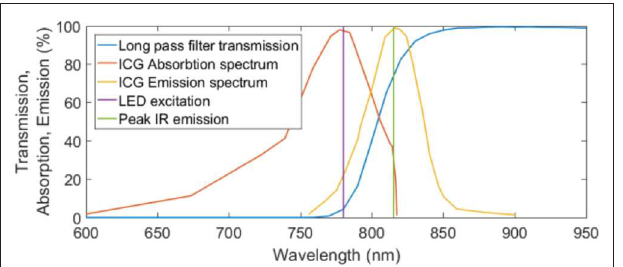
FIGURE 3 | Transmission, absorption, and emission spectra for the MIDOPT filter, ICG excitation, and ICG emission respectively. Peak IR excitation and the wavelength of the excitation LED are also shown.